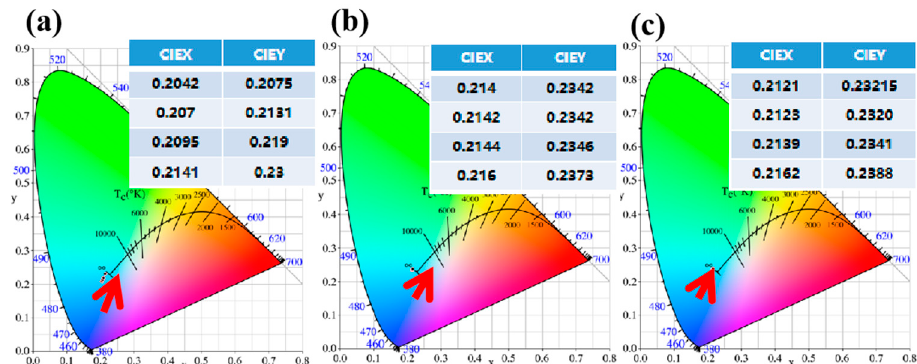
Figure 10. ( a – c ) The CIE chromaticity coordinates (x, y) of the three samples at 303, 393, 483, and 543 K.